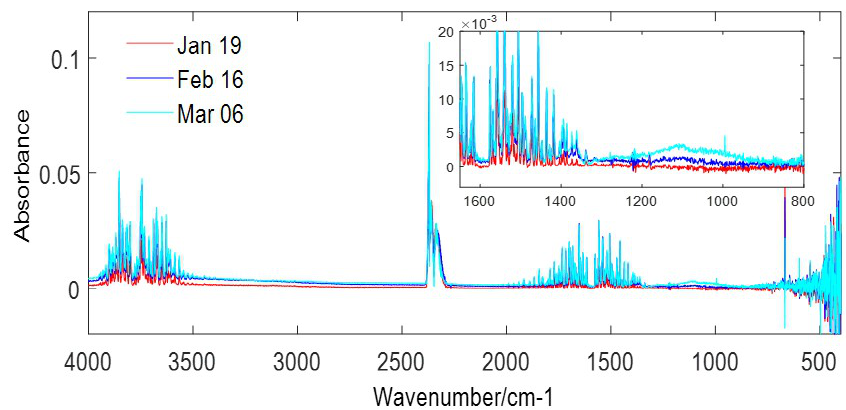
Figure 5. Absorption spectra of oil-dissolved gas obtained using the common method, i.e., A = − lg( I m 1 / I m 0 ) with the DGA analyzer developed based on a Fourier transform infrared (FT-IR) spectrometer. I m 0 means the luminous spectra were scanned with a working gas cell full of nitrogen. It was scanned on 19 January 2016. I m 1 means the luminous spectra were scanned with the working gas cell after DGA analyzer was put into use. The absorbances denoted with “Jan 19”, “Feb 16” and “Mar 06” mean that I m 1 was scanned on 19 January 2016, 16 February 2016 and 06 March 2016, respectively.